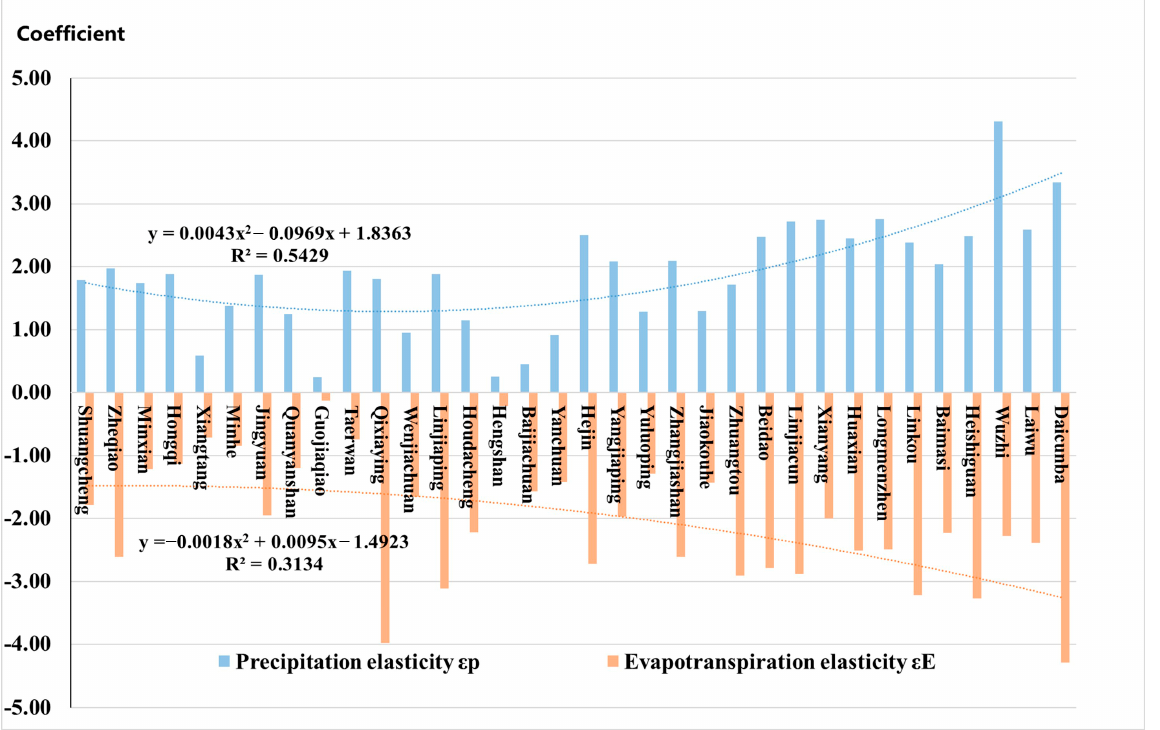
Figure 6. Elastic coefficient of precipitation and potential evapotranspiration at the control section of the tributaries of the Yellow River Basin.